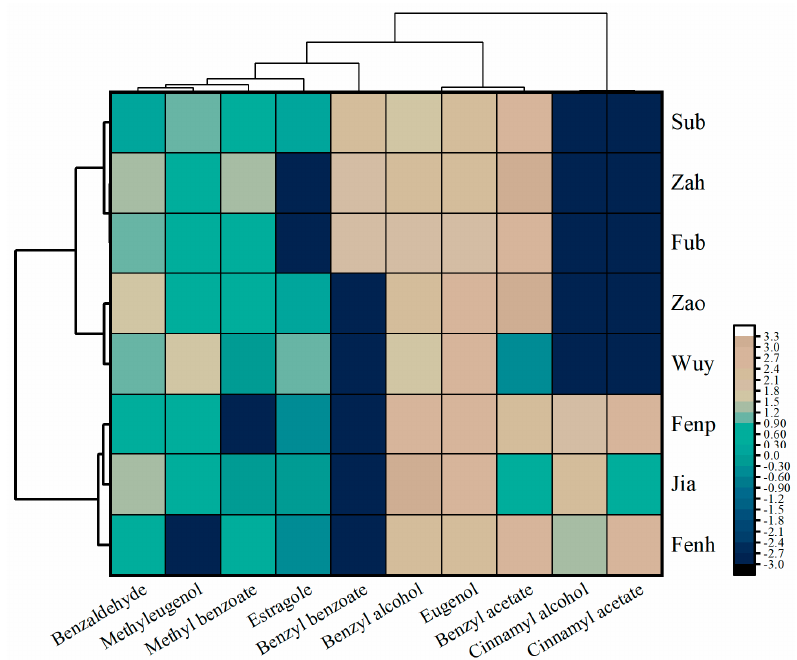
Figure 4. Heatmap of core VOCs and hierarchical cluster analysis of eight P. mume cultivars. The colour of the heatmap ranges from dark blue (value, –3.0) to brown (value, 3.3) in the natural logarithmic scale. Data are presented with means of biological replicates. The emission values were normalized by log 10 transformation.